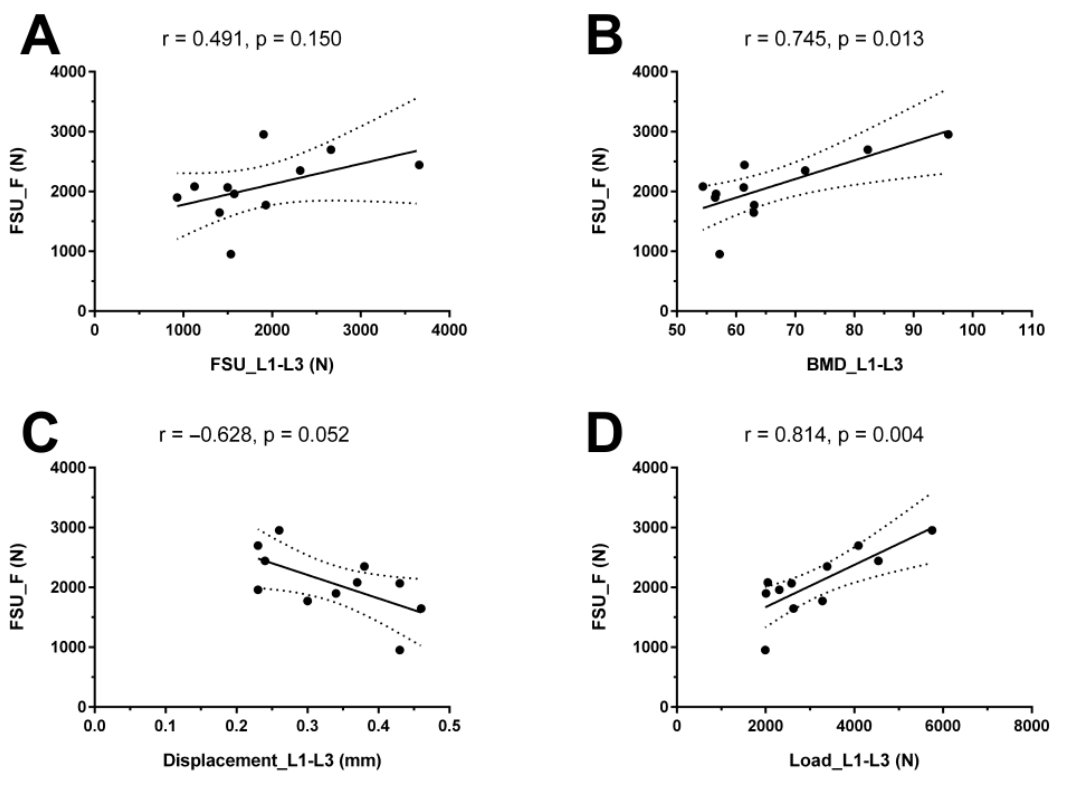
Figure 3. Correlation analyses with finite element models (FEMs). This graph depicts the correlation of the FEM of the functional spinal unit (FSU) centered at the level of the incidental osteoporotic vertebral fracture (VF) as the dependent variable ( y-axis , FSU_F) with the ( A ) FEM of the FSU including vertebrae L1 to L3 (FSU_L1–L3), ( B ) vBMD of L1 to L3 (BMD_L1–L3), ( C ) displacement of L1 to L3 (Displacement_L1–L3), and ( D ) load of L1 to L3 (Load_L1–L3). Individual values are given as single dots, together with the adjusted correlation coefficient r and related p -values of respective correlation analyses.